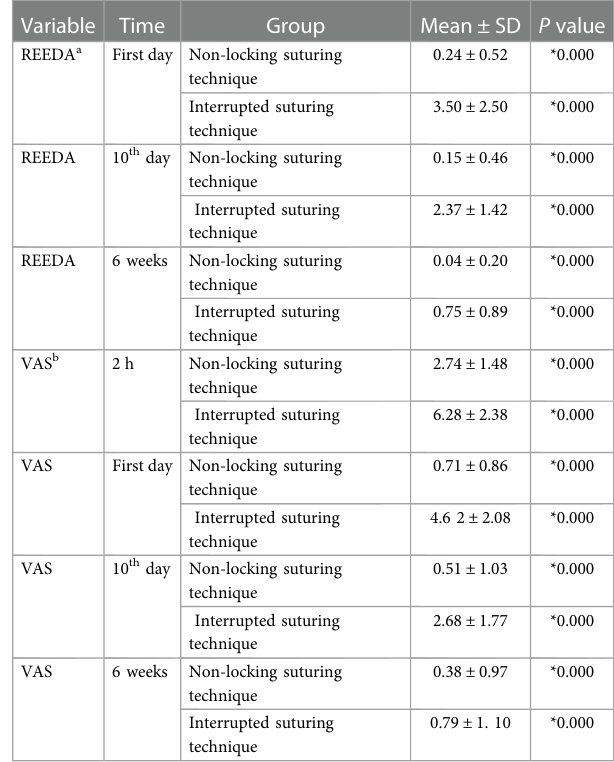
TABLE 2 Mean of visual analogue scale and redness, oedema, ecchymosis, discharge, approximation scale variables in the intervention and control